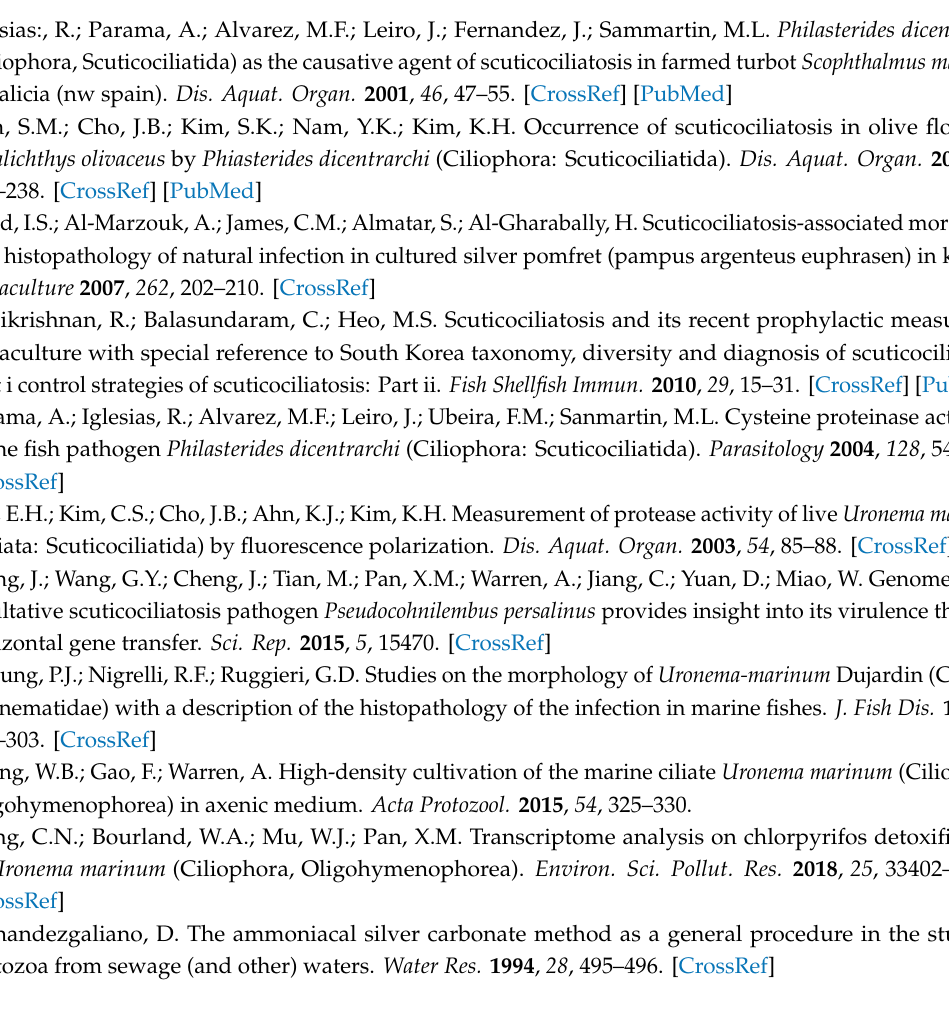
Figure S1. GC distribution of preliminarily assembled genome. Figure S2. Venn diagram showing specific and orthologous genes in U. marinum , P. persalinus , and I. multifiliis . Table S1. Sampling information and species identification for the five scuticociliates. Table S2. Number and type of segmental duplications in U. marinum and P. persalinus . WGD, whole-genome duplication. Table S3. Description of the 105 HGT genes in the U. marinum MAC